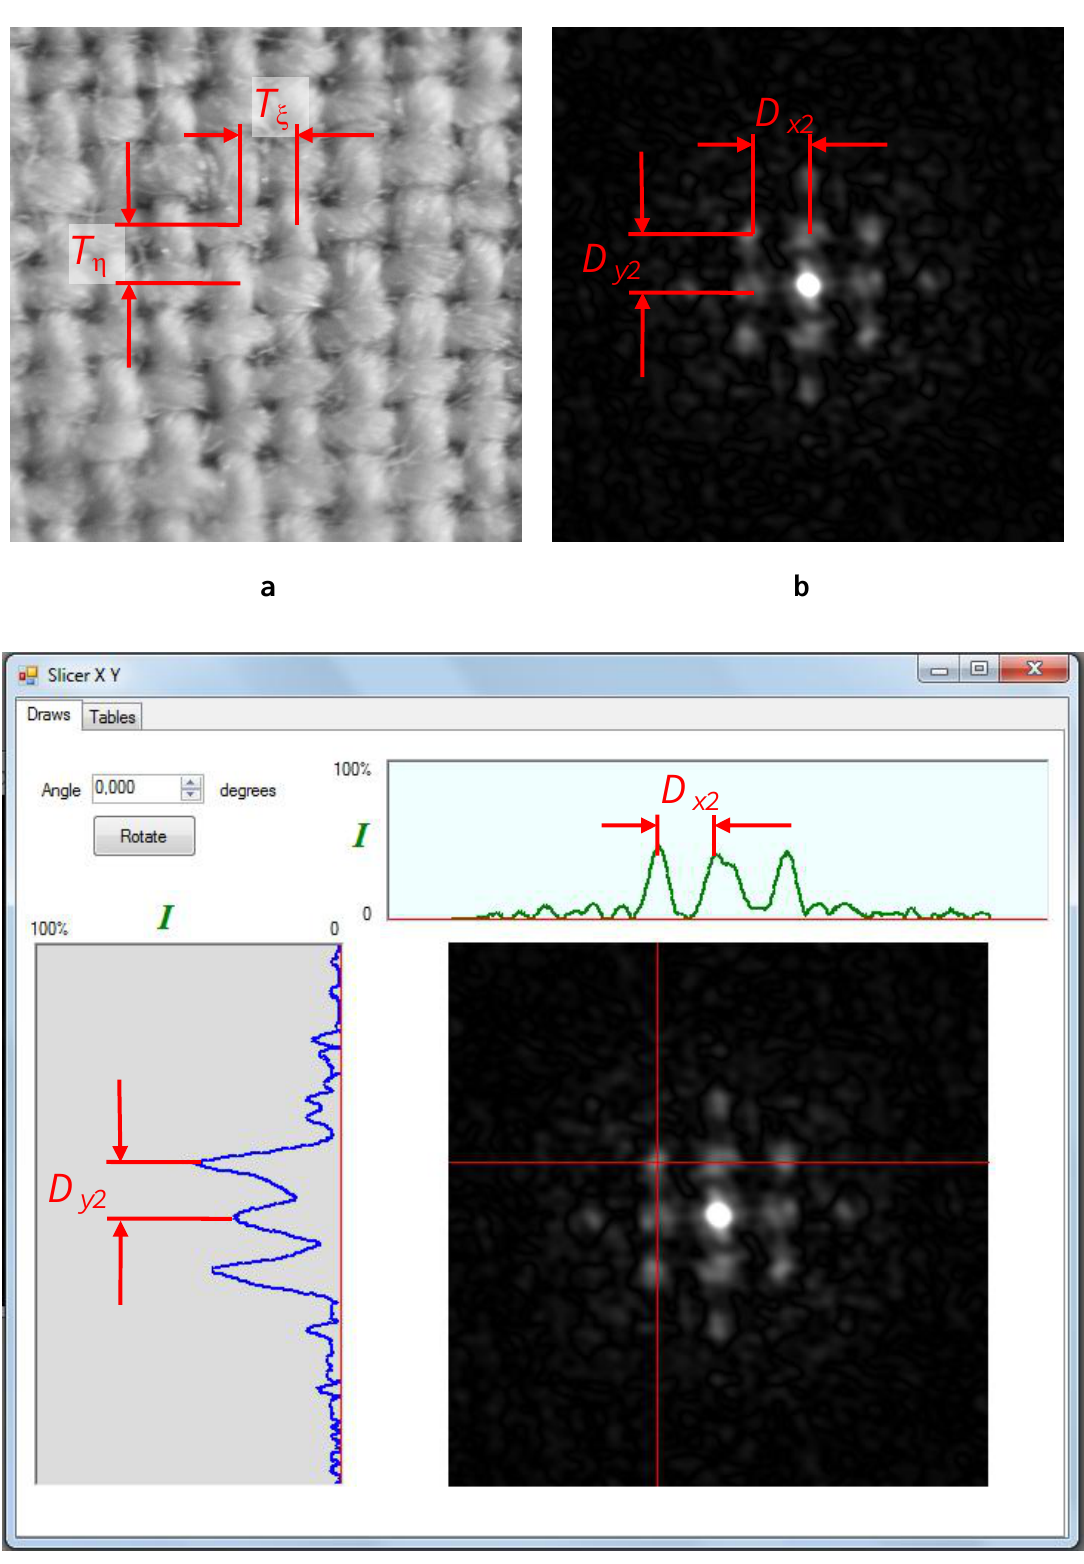
Figure 5. ( a ) The source image of woven cloth; ( b ) The resulting image after double diffraction pattern calculation using our method; ( c ) Screenshot of the program automatically detecting distances between units in periodical